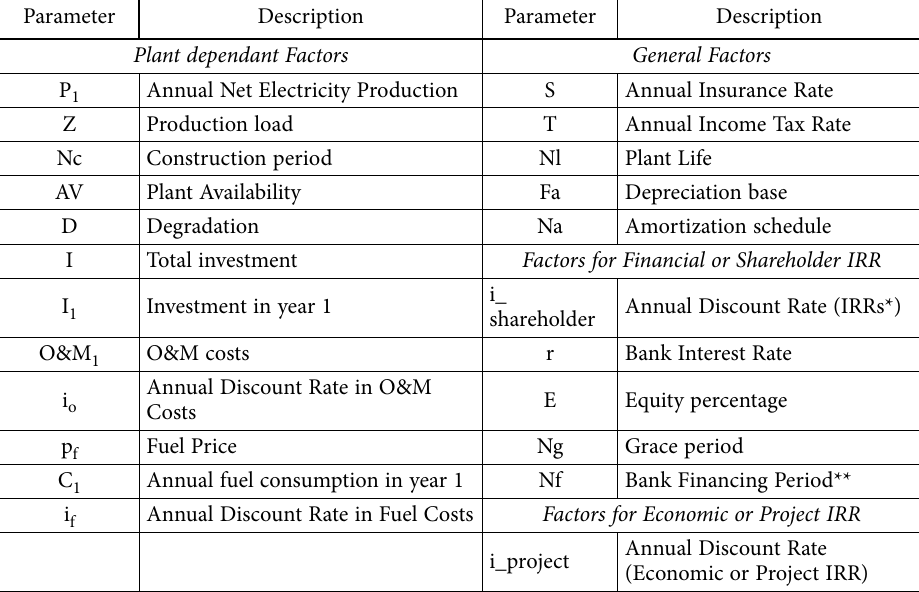
Table 2. Measurement of LCOE: